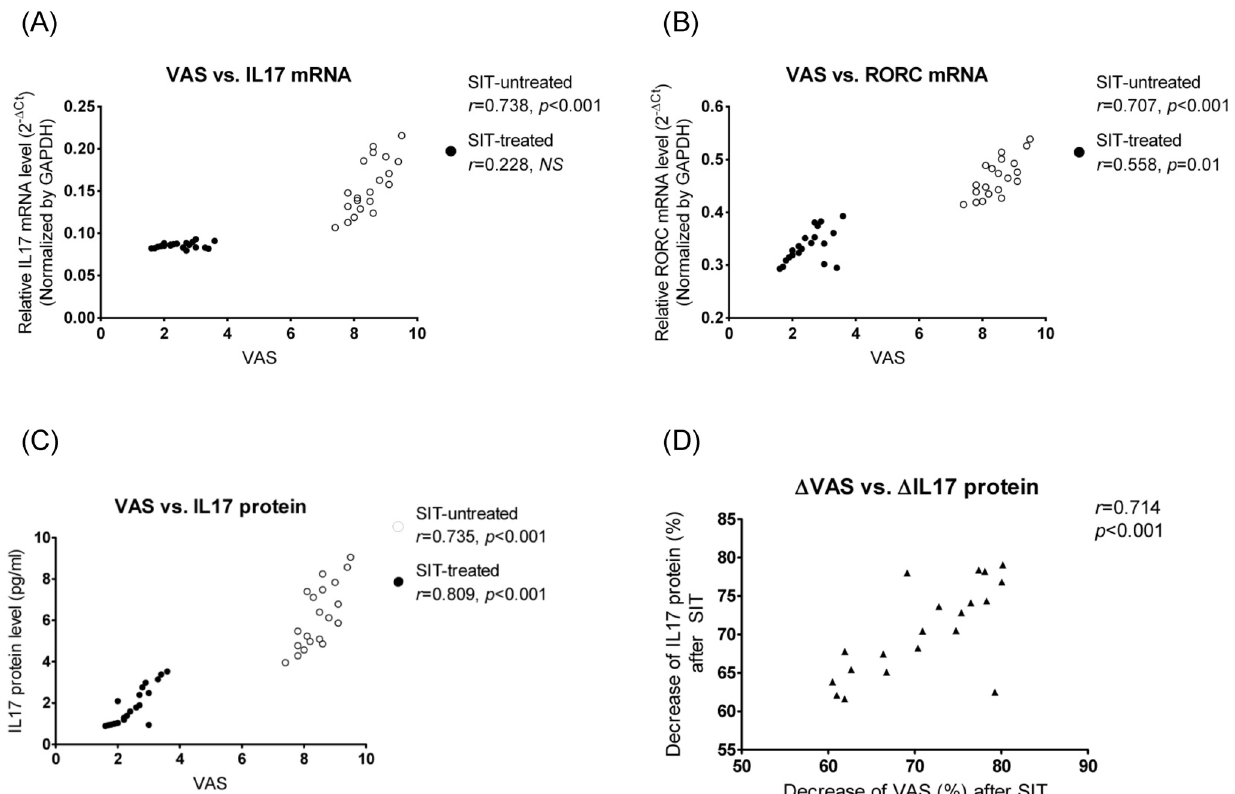
Figure 6. Relationship between VAS versus IL17 protein (A), IL17 mRNA (B), and RORC mRNA (C), and between changes of VAS versus changes of plasma IL17 protein (D) were also illustrated. D VAS referred to the ratio of (VAS SIT 2 2 VAS SIT + )/VAS SIT 2 , and D IL17 referred to the ratio (in percentage) of (IL17 SIT 2 2 IL17 SIT + )/IL17 SIT 2 ; Spearman correlation analysis was performed. ‘‘ NS ’’ indicates not significantly different.